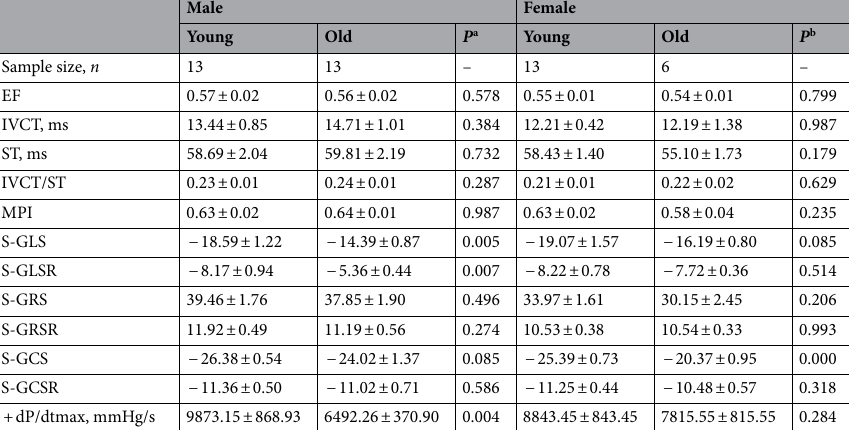
Table 5. Cardiac systolic functional parameters of the study population. a Between young and old males; b between young and old females. EF ejection fraction, IVCT isovolumetric contraction time, ST systolic time interval, MPI myocardial performance index, S-GLS systolic global longitudinal strain, S-GLSR systolic global longitudinal strain rate, S-GRS systolic global radial strain, S-GRSR systolic global radial strain rate, S-GCS systolic global circumferential strain, S-GCSR systolic global circumferential strain rate, + dp / dtmax the maximum rise rate of pressure in left